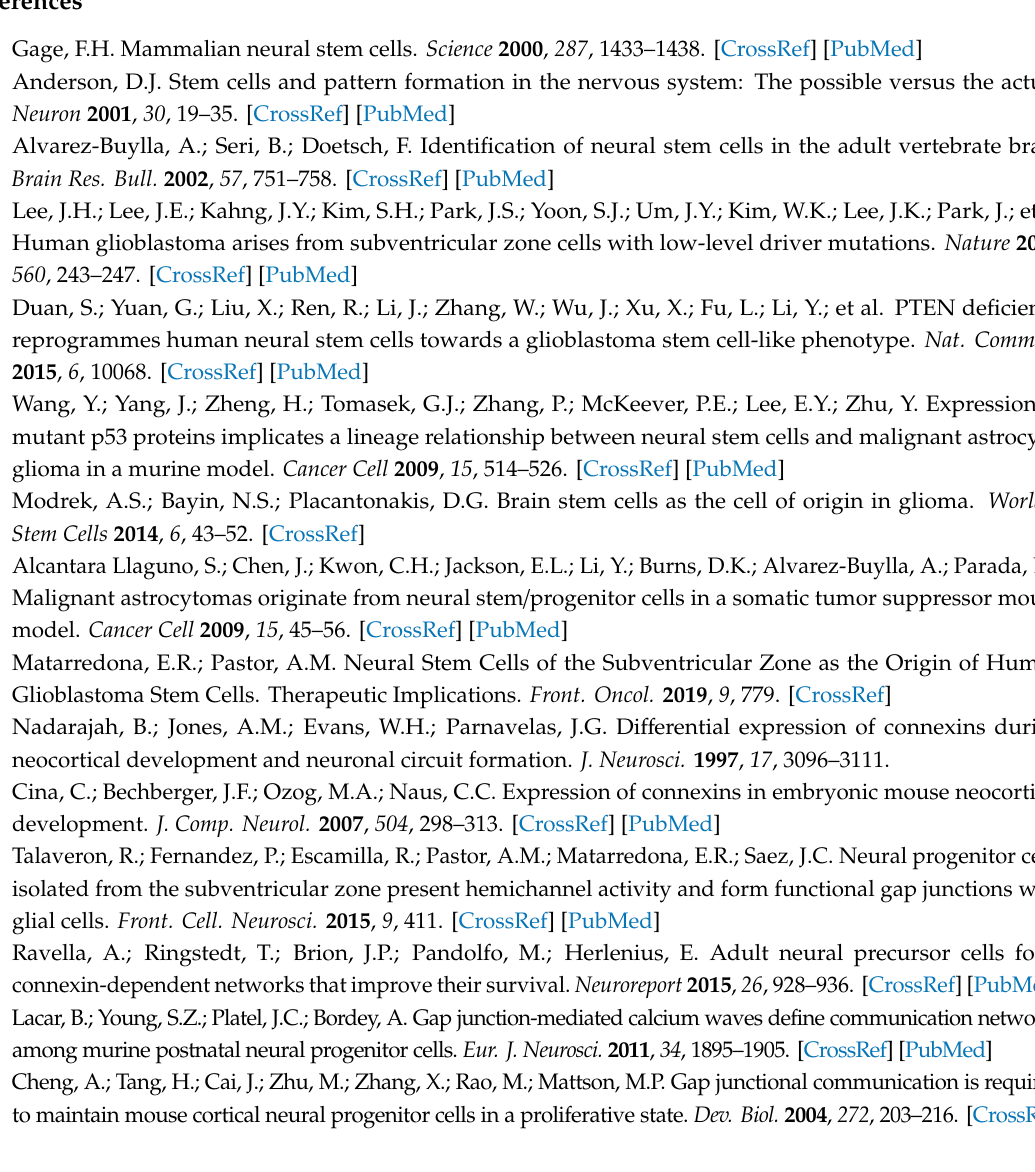
Figure A2. Effect of TAT-Cx43 266-283 on Cx43 expression in neural progenitor cells in differentiation conditions. Representative images showing Cx43 immunoreactivity (green) in neural progenitor cells grown in differentiation conditions (DC NPCs) treated with 25 µM TAT or TAT-Cx43 266-283 for 96 h. Cell nuclei were labeled with DAPI (blue). Bar: 50 µ m. Bar graphs show the percentage of Cx43-positive cells after 96 h of treatment in each experimental condition. Results are the mean ± SEM ( n = 6 TAT, n = 6 TAT-Cx43 266–283 , not significant; Student’s t